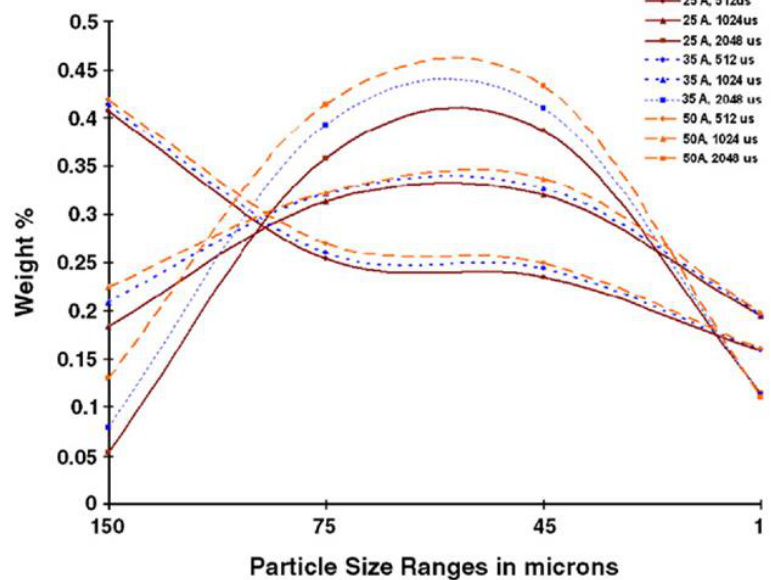
Figure 14. Particle size distributions in deionized water with varying current intensities and pulse widths [170].